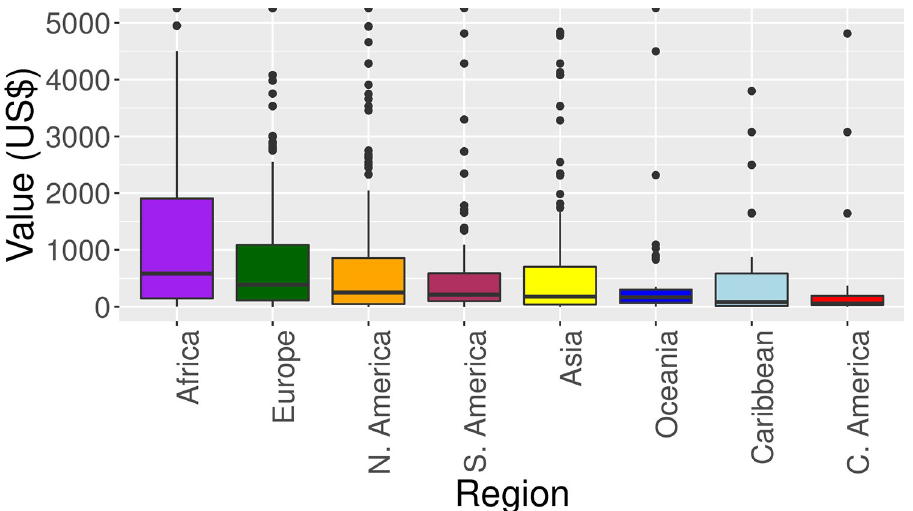
Fig 2. Boxplots depicting average price of seizures into the USA from each region. Values beyond US$ 5000 are not shown.